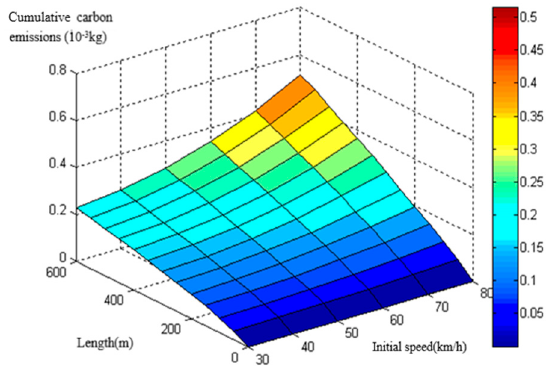
Figure 3. CO 2 emission database of heavy-duty diesel trucks with a radius of 200 m.